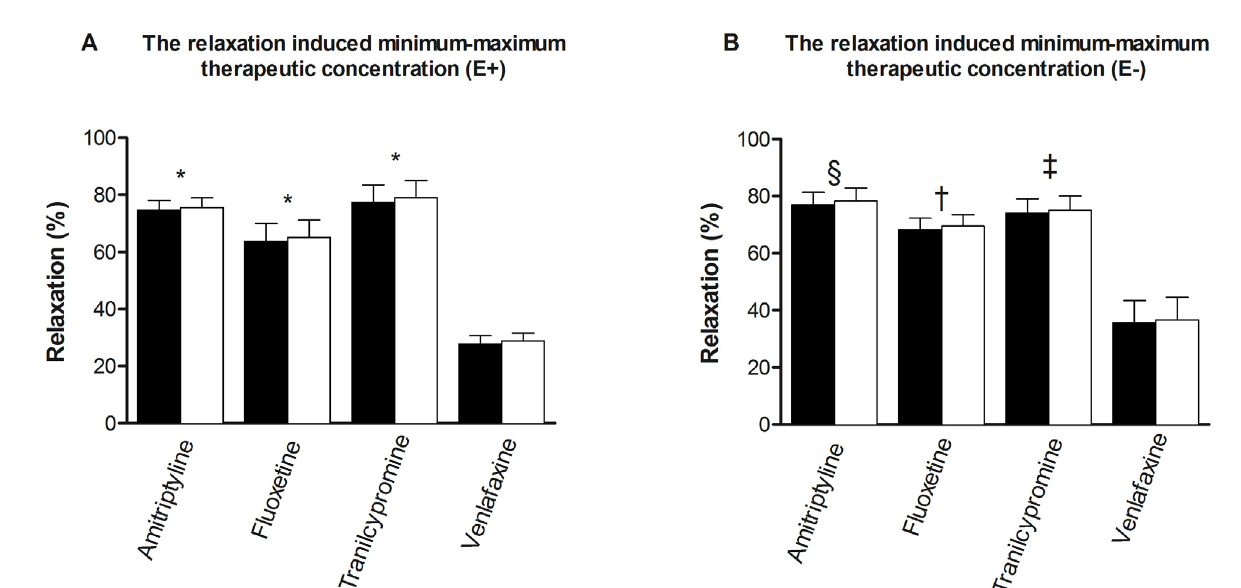
Fig. 2 – Statistical comparison of relaxations (%) at minimum (black) and maximum (white) therapeutic plasma concentrations of amitriptyline, fluoxetine, tranylcypromine and venlafaxine in isolated human saphenous vein grafts with (A) Endothelium intact precontracted with submaximal phenylephrine (3×10 -6 M) and (B) Endothelium denuded (n=8 for each